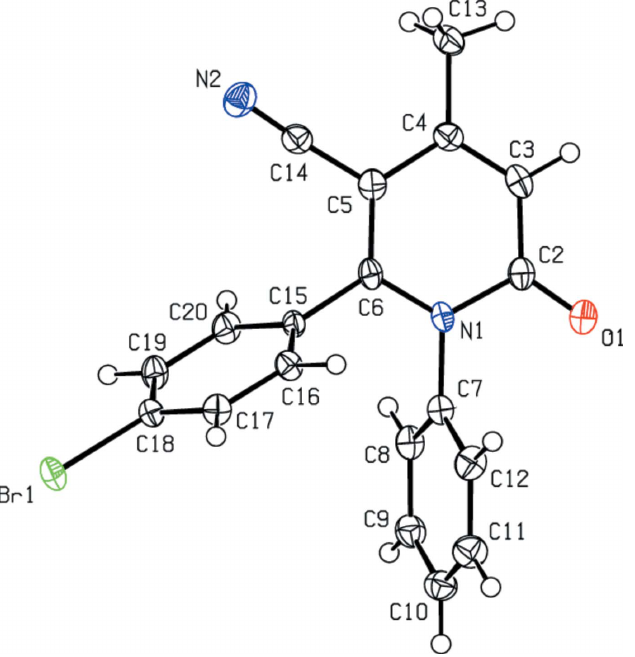
Figure 2 The molecular structure of the title compound. Displacement ellipsoids are drawn at the 50% probability level.